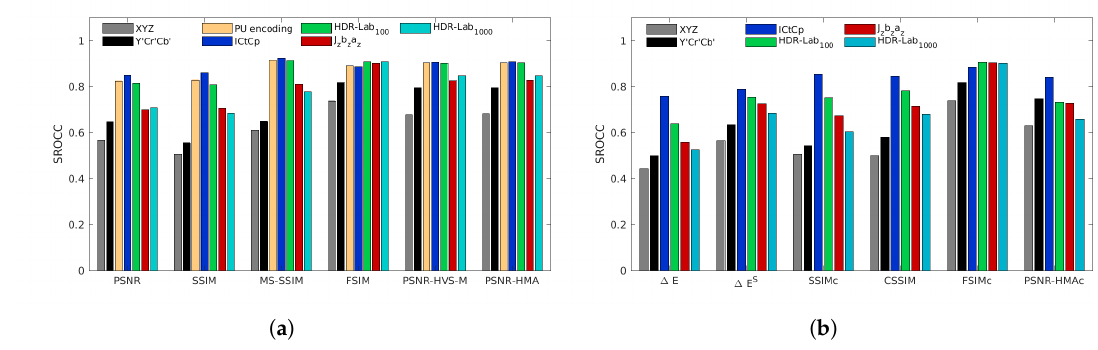
Figure 9. SROCC performances for the Zerman et al. database for color-blind quality metrics ( a ) and for color quality metrics ( b